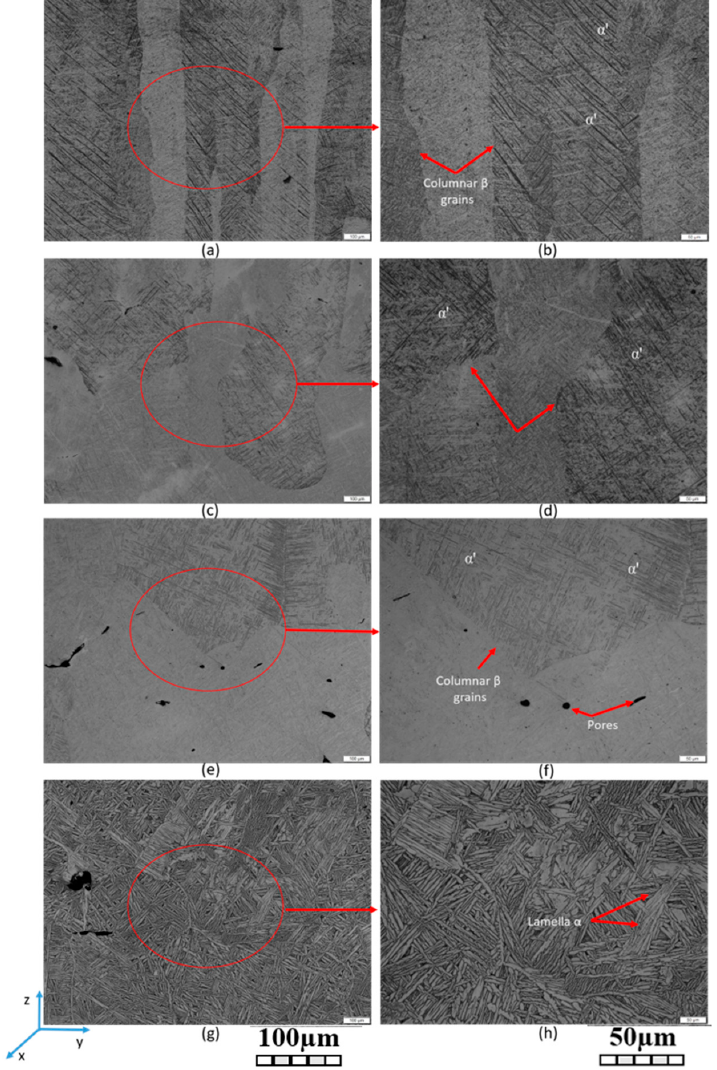
Figure 4. Optical microstructures of the samples: ( a ) As-built; ( b ) as-built zoom in; ( c ) water quenching (WQ); ( d ) WQ zoom in; ( e ) air cooling (AC); ( f ) AC zoom in; ( g ) furnace cooling (FC); ( h ) FC zoom in.